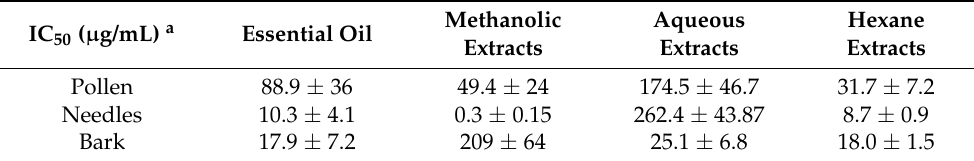
Table 1. IC 50 values for different extracts (hexane, methanolic, aqueous extracts, and essential oils) prepared from P. eldarica. Data are expressed as mean ± standard deviation (SD), representative of three independent experiments.